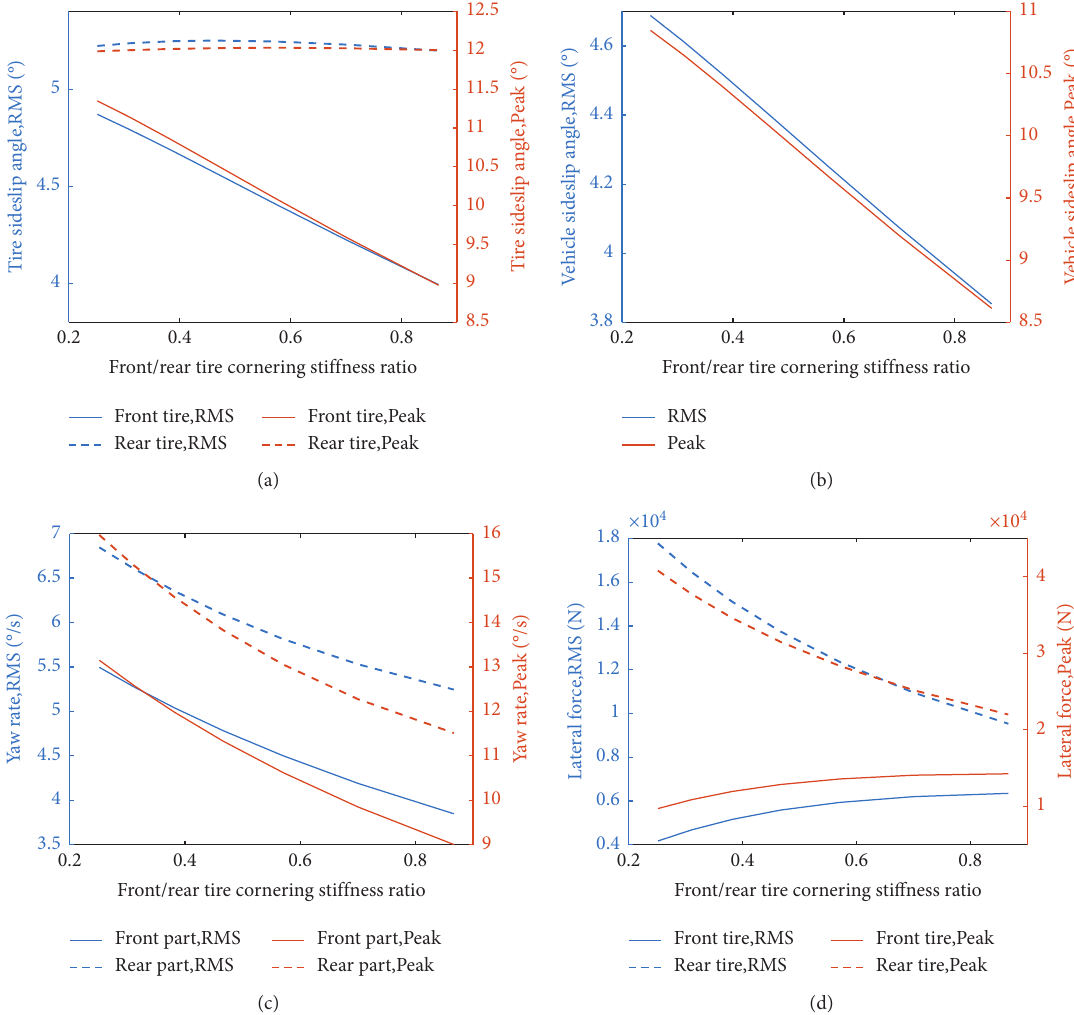
Figure 8: Vehicle performance of the tire cornering stiffness ratio variation. (a) RMS and peak value of tire sideslip angle. (b) RMS and peak value of vehicle sideslip angle. (c) RMS and peak vehicle yaw rate. (d) RMS and peak value of lateral